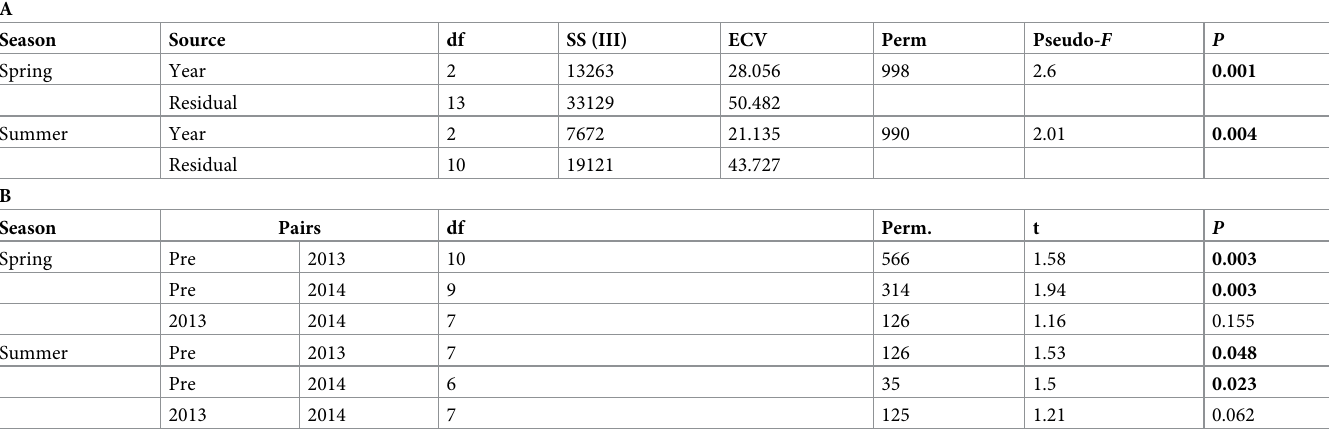
Table 7. Estuary prey energy PERMANOVA results for: (a) Main test of year, and b) Pairwise comparisons for year.